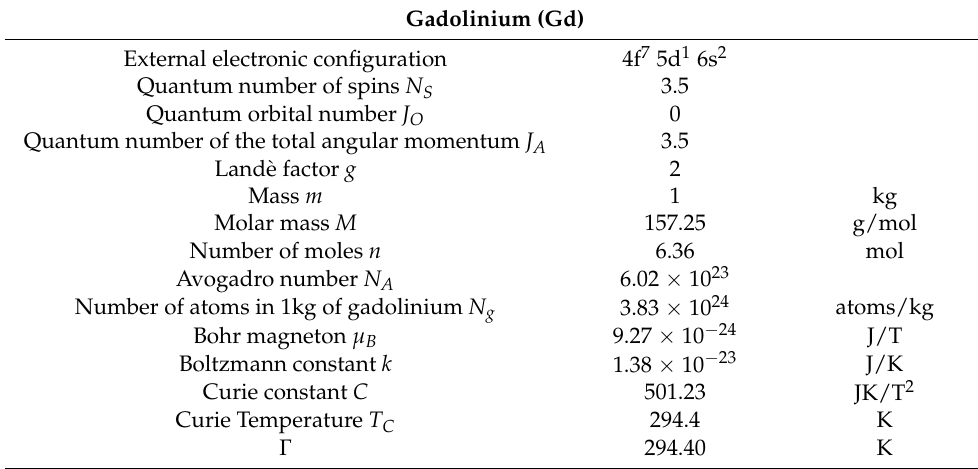
Figure 9. Trend of the COP of the Ericsson cycle according to the Curie-Weiss law as the variation of T cold for two fixed T hot values. Table 2. Data used for the COP calculation considering gadolinium as magnetocaloric